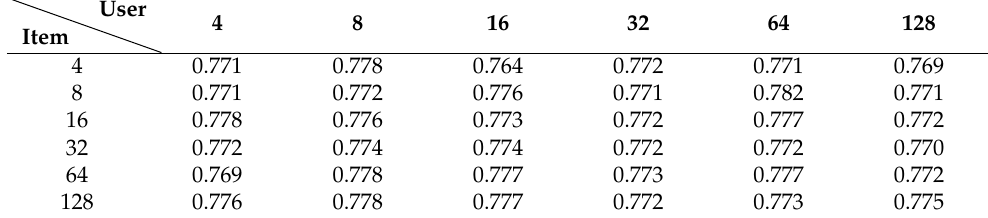
Table 7. The effect of size of triple set on F1 in Book-Crossing. Item